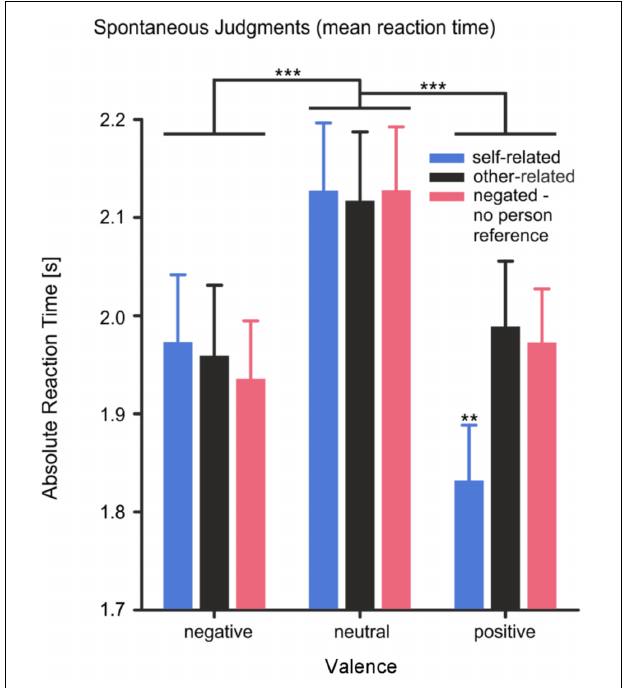
FIGURE 2 | Mean reaction times of spontaneous judgments (absolute values). The reaction time represents the time subjects needed to spontaneously judge the valence of the pronoun-noun pairs. Error bars depict SEM. ∗∗ p < 0.01, ∗∗∗ p < 0.001, FDR corrected.